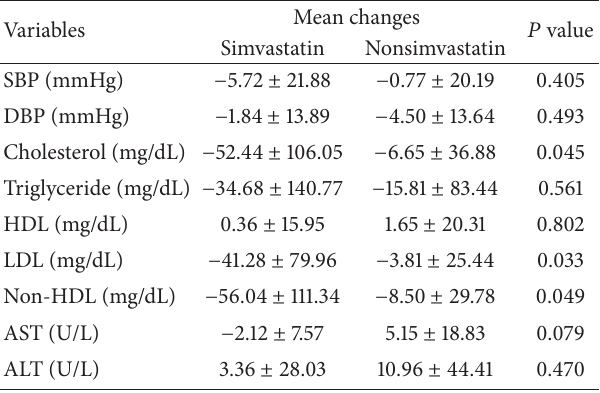
Table 2: Changes of metabolic profiles after 53 weeks of statin